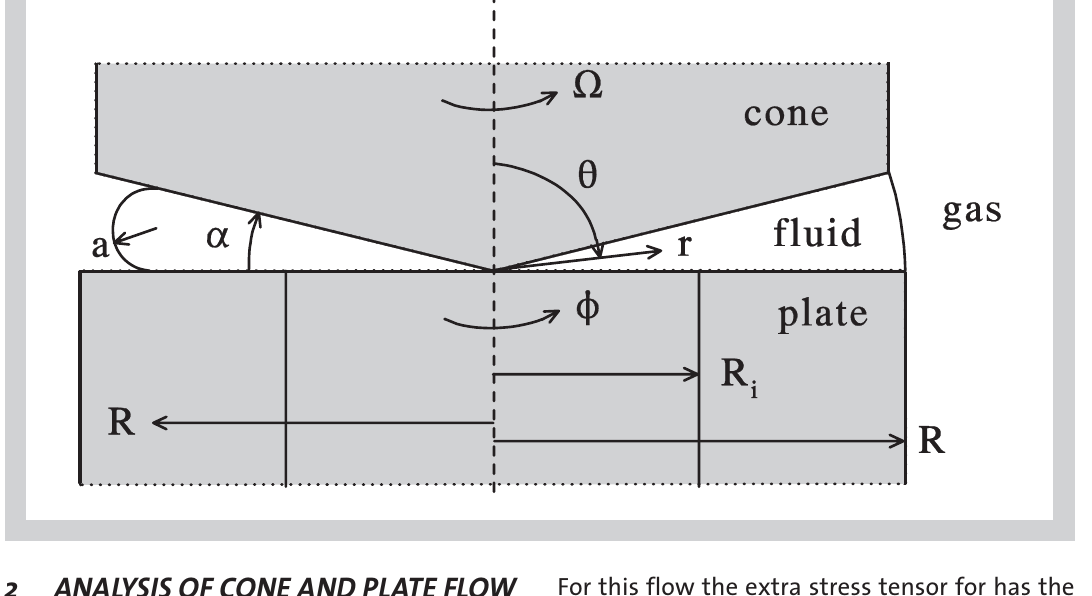
Figure 1: Schematic of cone and par- titioned plate geometry. Right side shows spherical free surface and left side shows bulged free